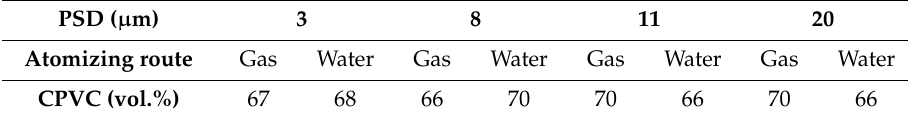
Table 4. E ff ect of particle size distribution (PSD) and atomization routes on the CPVC values [50].